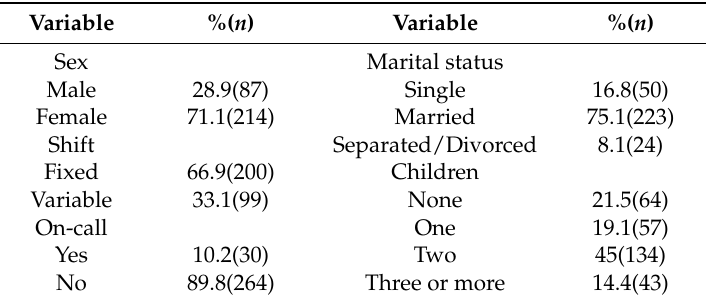
Table 1. Descriptive data for the qualitative study variables.